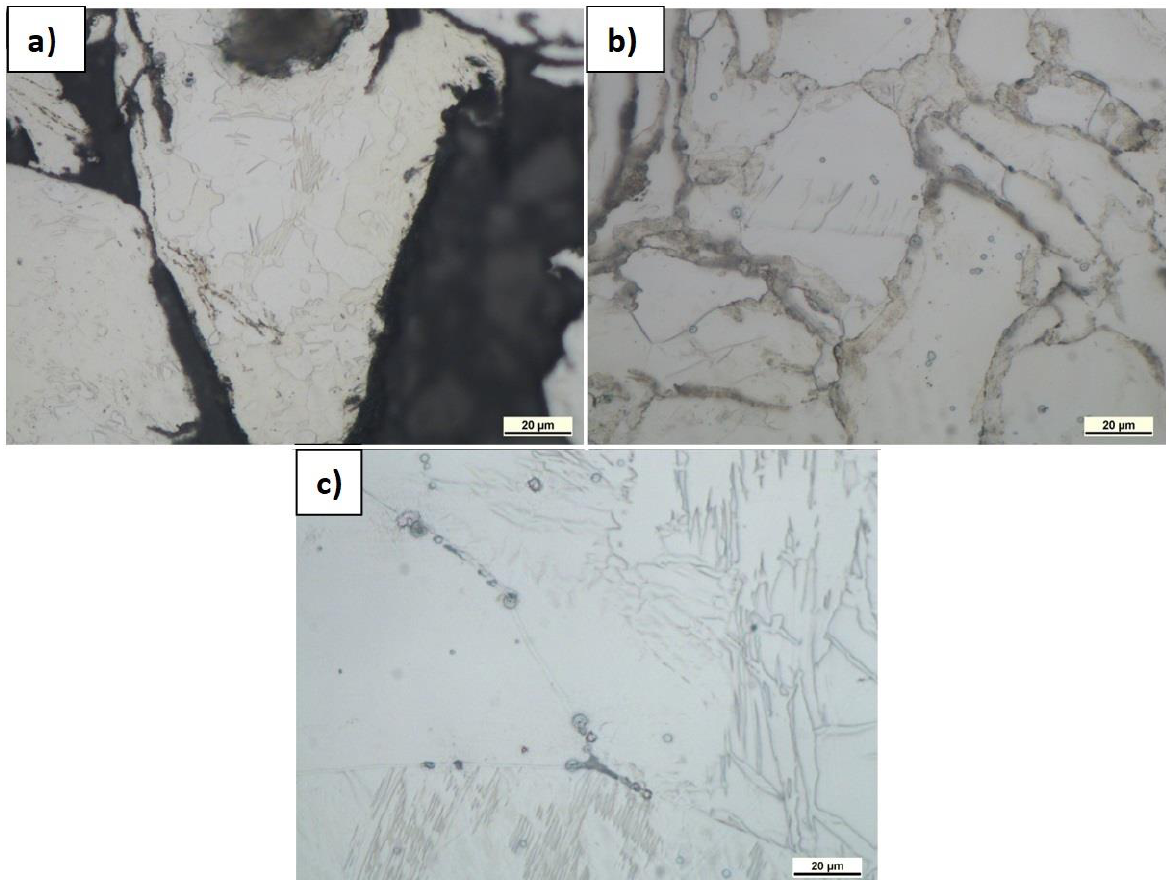
Figure 2. LM micrographs of raw material cross sections (etched): ( a ) Mg powder embedded in resin, ( b ) sintered Mg, ( c ) cast Mg.